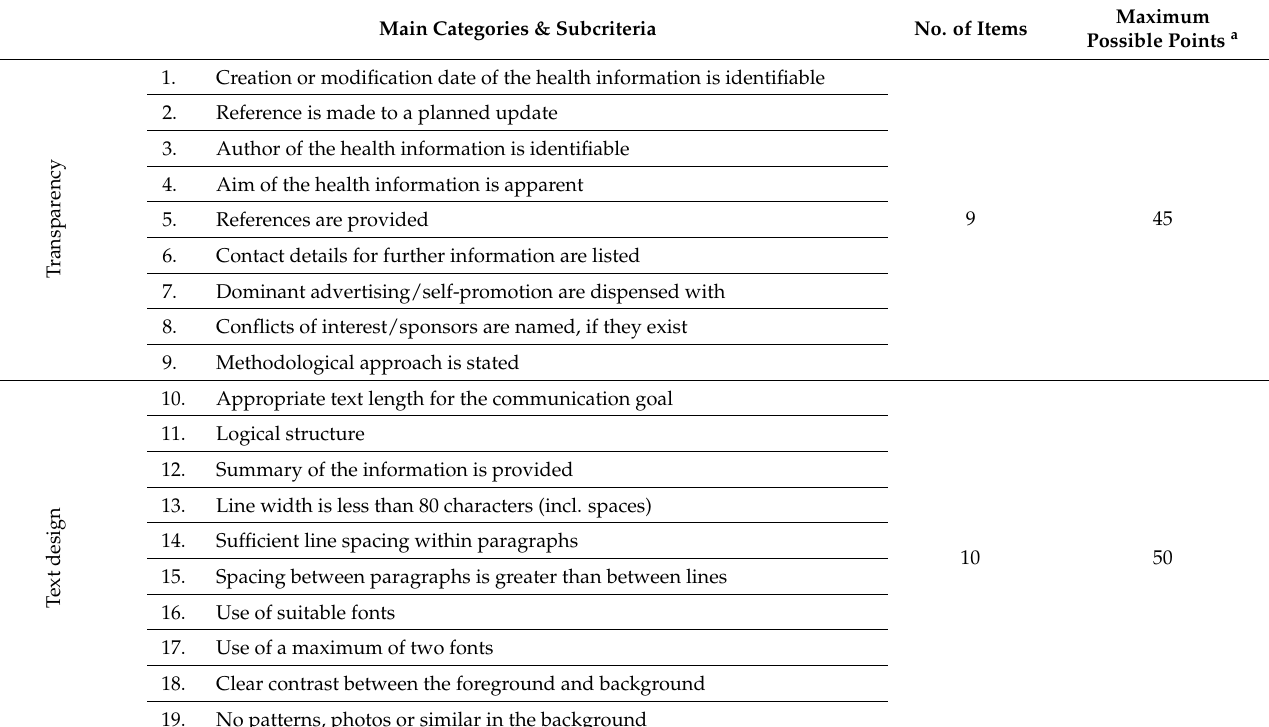
Table 1. Evaluation catalog of criteria on colorectal cancer screening information (modified from